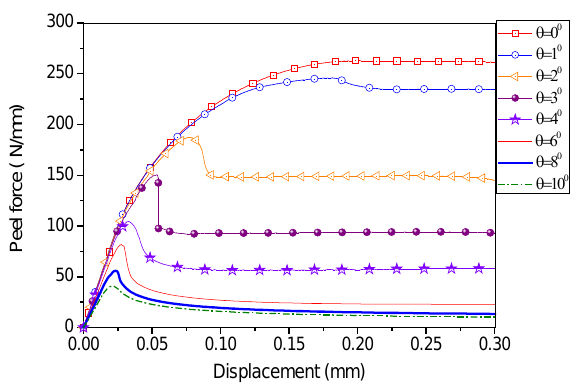
Figure 9. Load-displacement behavior for different peel angle.